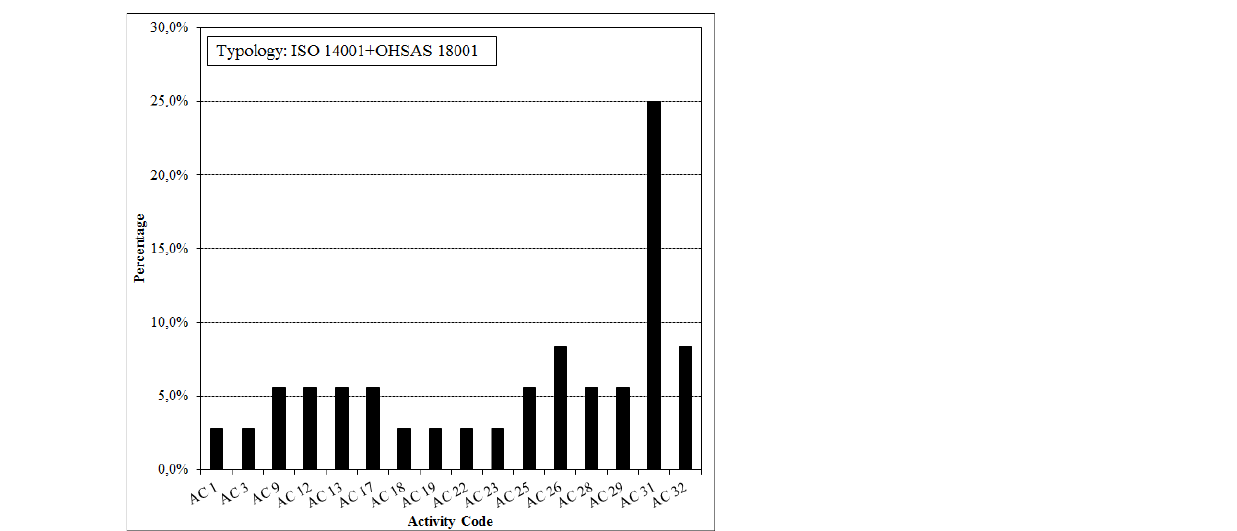
Figure 13. Integrated Typology ISO 14001+OHSAS 18001: Breakdown by activity